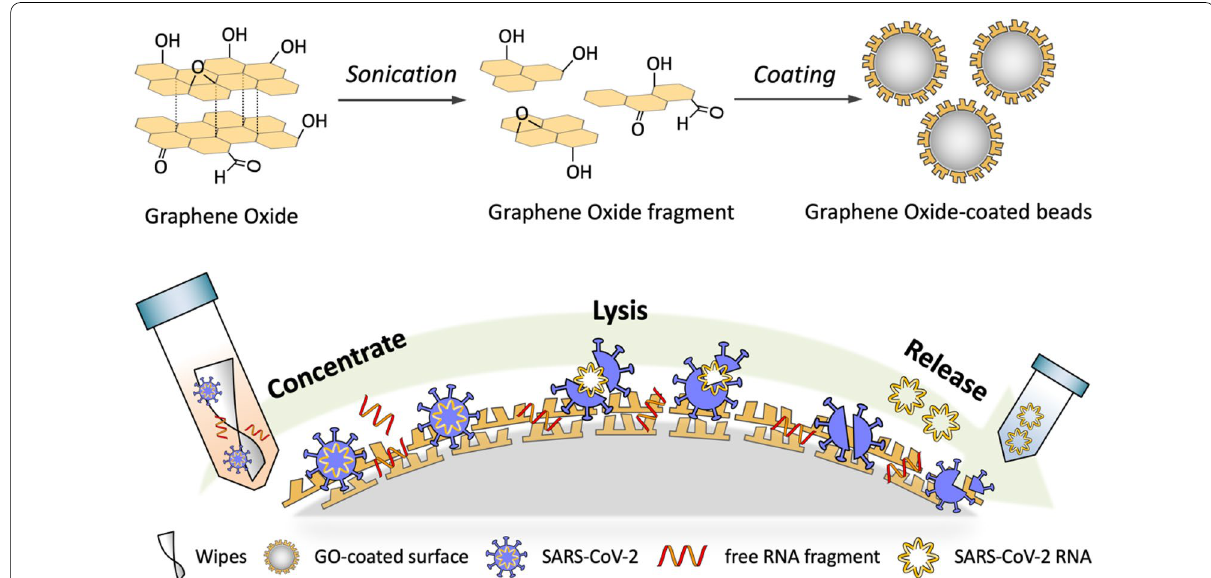
Fig. 1 Schematic illustration of GO based sample preparation system for nucleic acid‑based detection of SARS‑CoV‑2, not free RNA